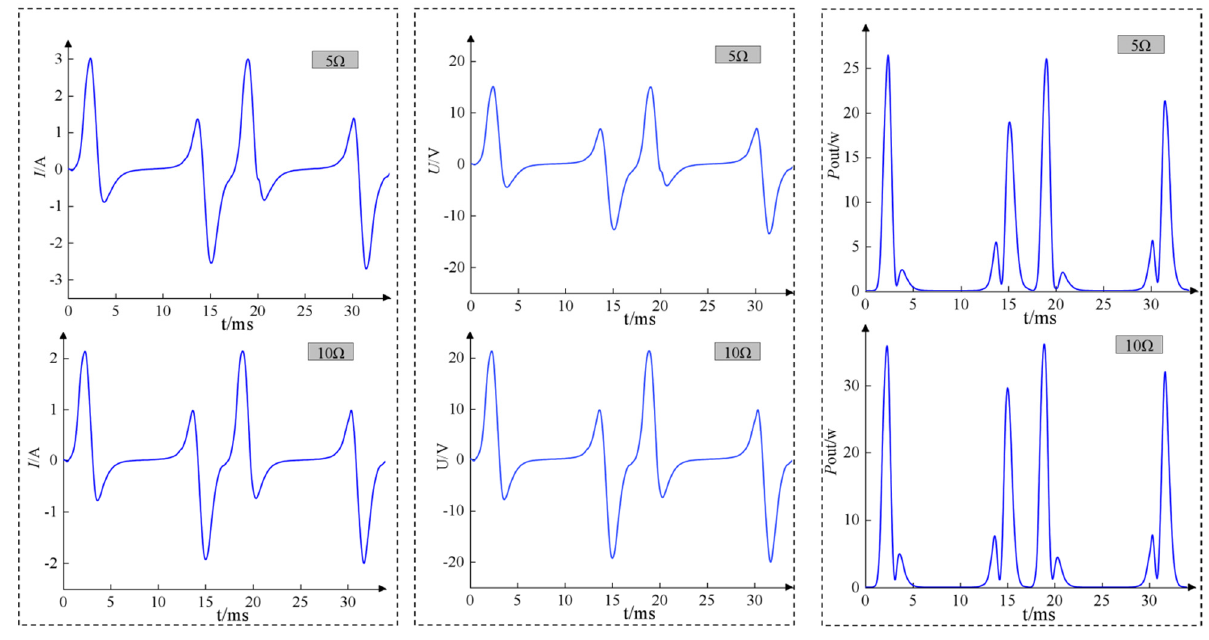
12 of 22 Figure 6. No − load simulation results: ( a ) air gap magnetic density curve; ( b ) magnetic chain change curve; ( c ) electric potential variation curve.